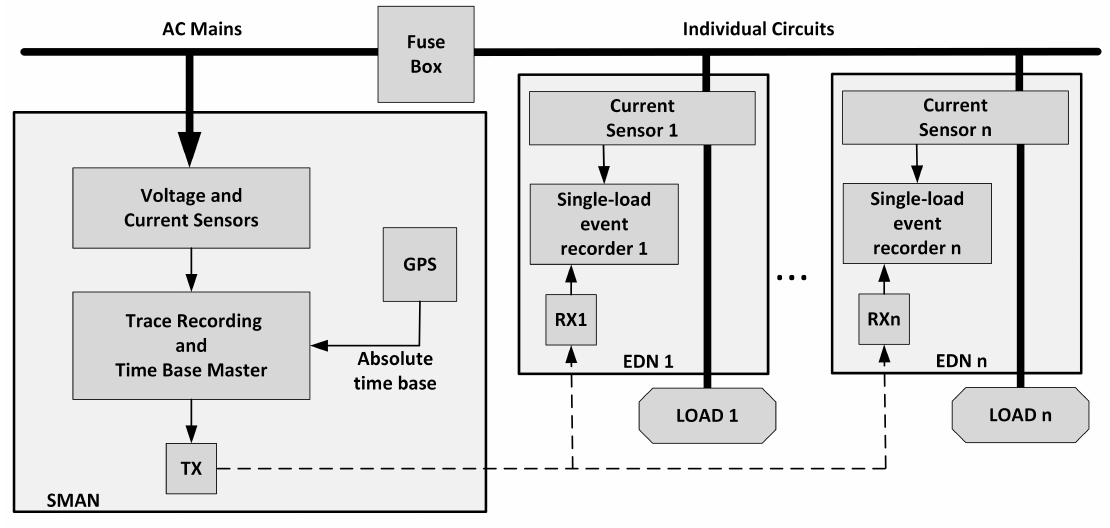
Figure 8. Overview of the architecture for collecting a natural load shaping